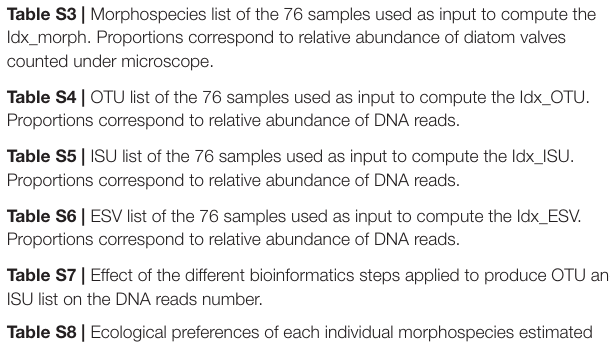
Table S6 | ESV list of the 76 samples used as input to compute the Idx_ESV. Proportions correspond to relative abundance of DNA reads. Table S7 | Effect of the different bioinformatics steps applied to produce OTU and ISU list on the DNA reads number. Table S8 | Ecological preferences of each individual morphospecies estimated during the training test phase of the Idx_morph, represented by the sensitivity and the indicator value. Each value corresponds to an average of the values obtained during the 100 times cross validation procedure. Table S9 | Ecological preferences of each individual OTU estimated during the training test phase of the Idx_OTU, represented by the sensitivity and the indicator value. Each value corresponds to an average of the values obtained during the 100 times cross validation procedure. Table S10 | Ecological preferences of each individual ISU estimated during the training test phase of the Idx_ISU, represented by the sensitivity and the indicator value. Each value corresponds to an average of the values obtained during the 100 times cross validation procedure. Table S11 | Ecological preferences of each individual ESV estimated during the training test phase of the Idx_ESV, represented by the sensitivity and the indicator value. Each value corresponds to an average of the values obtained during the 100 times cross validation